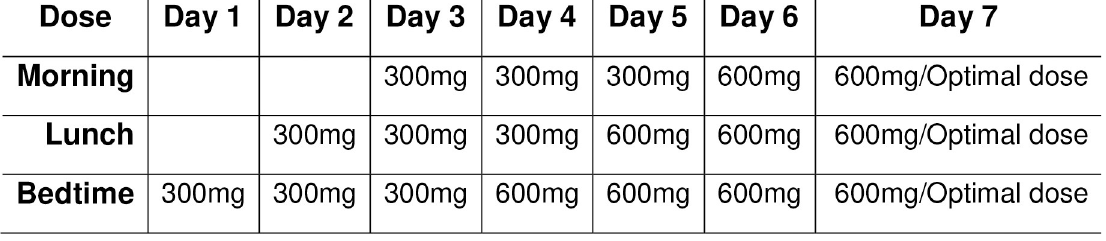
Fig 2. Dose titration scheme during the 1 st week of the